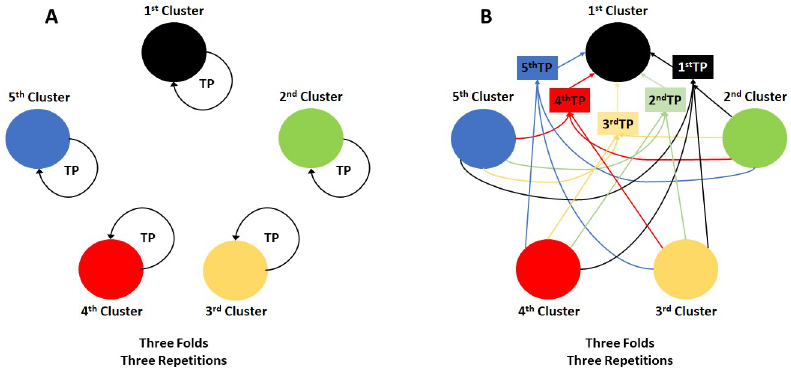
Fig 1. Cross validations performed to estimate the effect of population structure in genomic selection. A . 2 nd cross validation strategy–Within-cluster cross validation formed by discriminant analysis of principal components (DAPC); B . Illustration of between-clusters cross validation for DAPC cluster 1: 3 rd cross-validation strategy–cross validation with training population composed of a third part of DAPC clusters 2–5 and validation in a third part of DAPC cluster 1 ( 1 st TP ); 4 th cross-validation strategy–cross validation with the training population composed by a third part of three of the DAPC clusters ( 2 nd , 3 rd 4 th , and 5 th TPs ). Therefore, the first training population ( 1 st TP ) is formed from the four remaining DAPC clusters (3 rd cross validation strategy), while the second, third, fourth and fifth training populations ( 2 nd , 3 rd 4 th and 5 th TPs ) were each created from only three of those four DAPC clusters (4 th cross validation